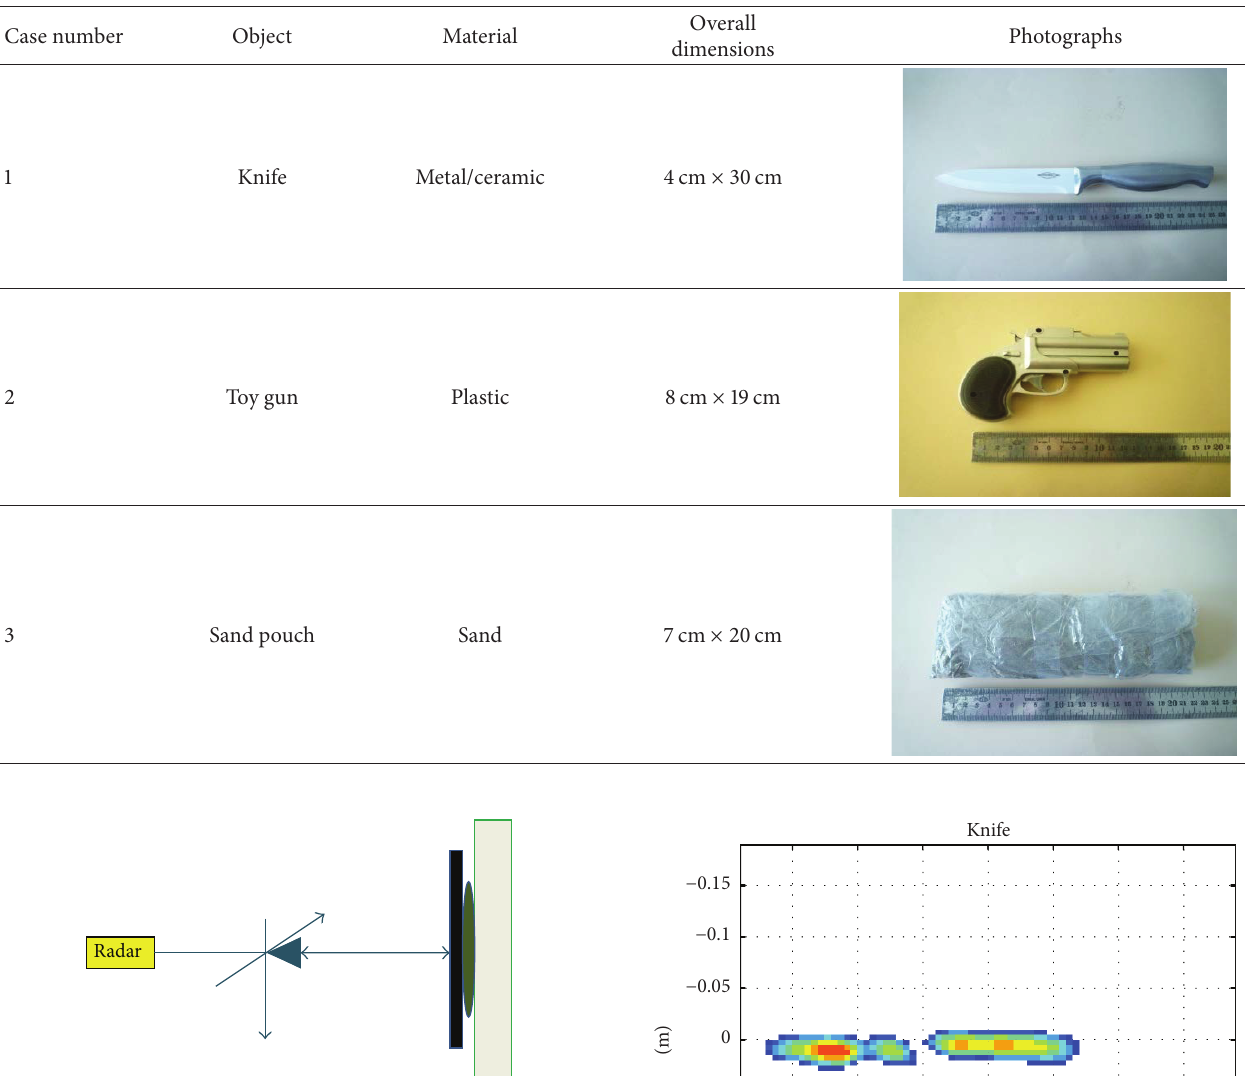
Table 3: List, description, and photographs of imaged objects.